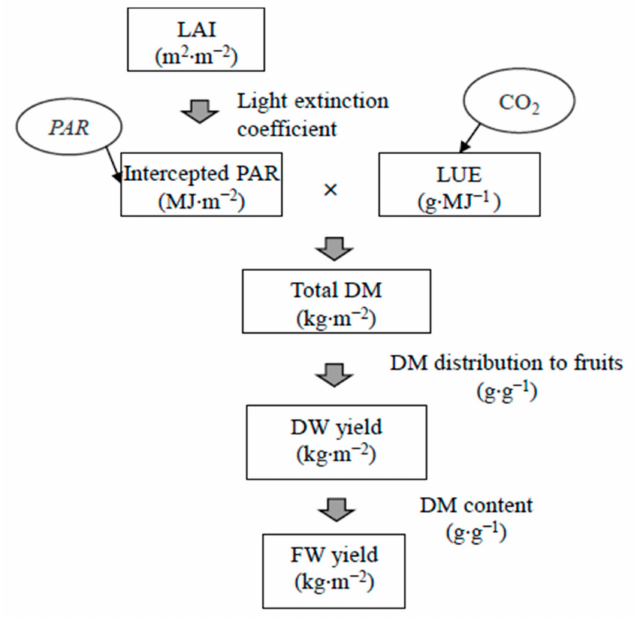
Figure 2. Flow chart for the calculation of yield and dry matter production (Saito, 2020a). LAI, leaf area index; PAR, photosynthetically active radiation; LUE, light-use efficiency; DM, dry matter; DW, dry weight; FW, fresh